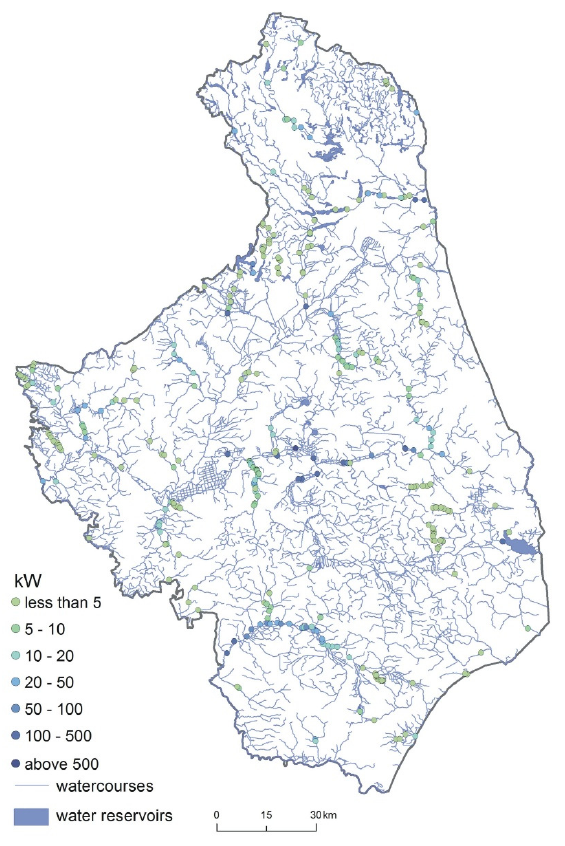
dams is 7.4 MW (Figure 15).